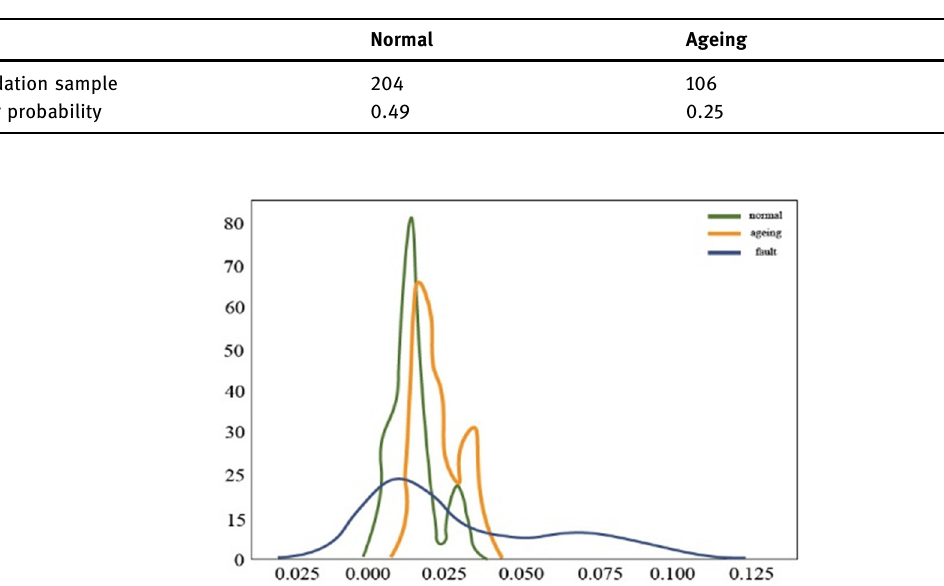
Figure 3: FCA probability density